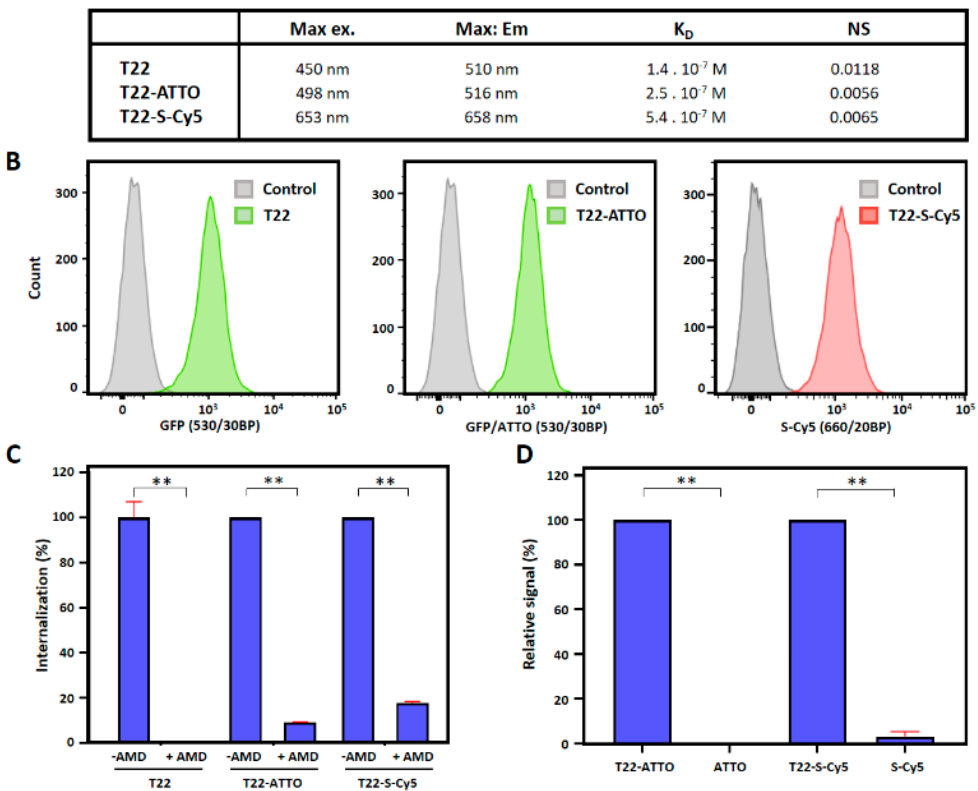
Figure 3. CXCR4-mediated cell internalization of nanoconstructs. ( A ) Biophysical properties of T22-GFP-H6 (T22), T22-GFP-H6-ATTO (T22-ATTO) and T22-GFP-H6-S-Cy5 (T22-S-Cy5) nanoparticles. ( B ) T22-GFP-H6 (T22) nanoparticles, and labeled T22-GFP-H6-ATTO (T22-ATTO) and T22-GFP-H6-S-Cy5 (T22-S-Cy5) nanoparticles internalization in cultured CXCR4 + Toledo cells monitored by flow cytometry upon 1 h of exposure. Grey peak overlays show control cells auto-fluorescence. 530 / 30BP indicates 515–545 nm bandpass filter, and 660 / 20BP indicates 650–670 nm bandpass filter. ( C ) CXCR4-mediated internalization in presence and absence of the CXCR4 specific antagonist AMD3100, upon 1 h of exposure. ( D ) Background fluorescence signal upon incubation of free ATTO488 (ATTO) and Sulfo-Cy5 (S-Cy5) in Toledo cells for 1 h. Fluorescence signal of free samples is shown relative to their respective nanoconjugate signals. Significant differences at p < 0.01 are indicated as **.